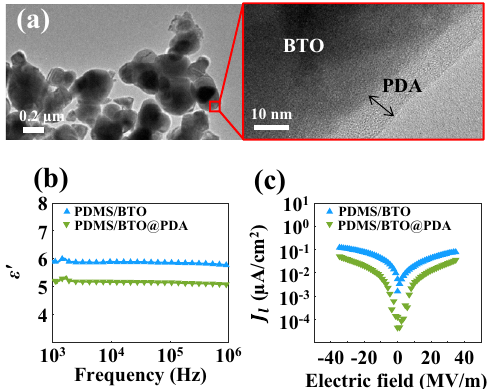
Figure 5. Characterizations of the BTO@PDA and PDMS/BTO@PDA composites. ( a ) TEM images of BTO@ PDA, including a magnified view of the PDA layer, and the ( b ) dielectric permittivities current densities ( J l ) of the PDMS/BTO and PDMS/BTO@PDA composites with BTO concentrations of 20